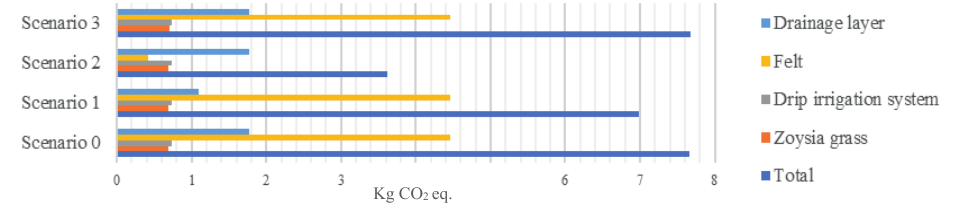
Fig. 6. Sensitivity analysis results through IPCC 2013 GWP 100y